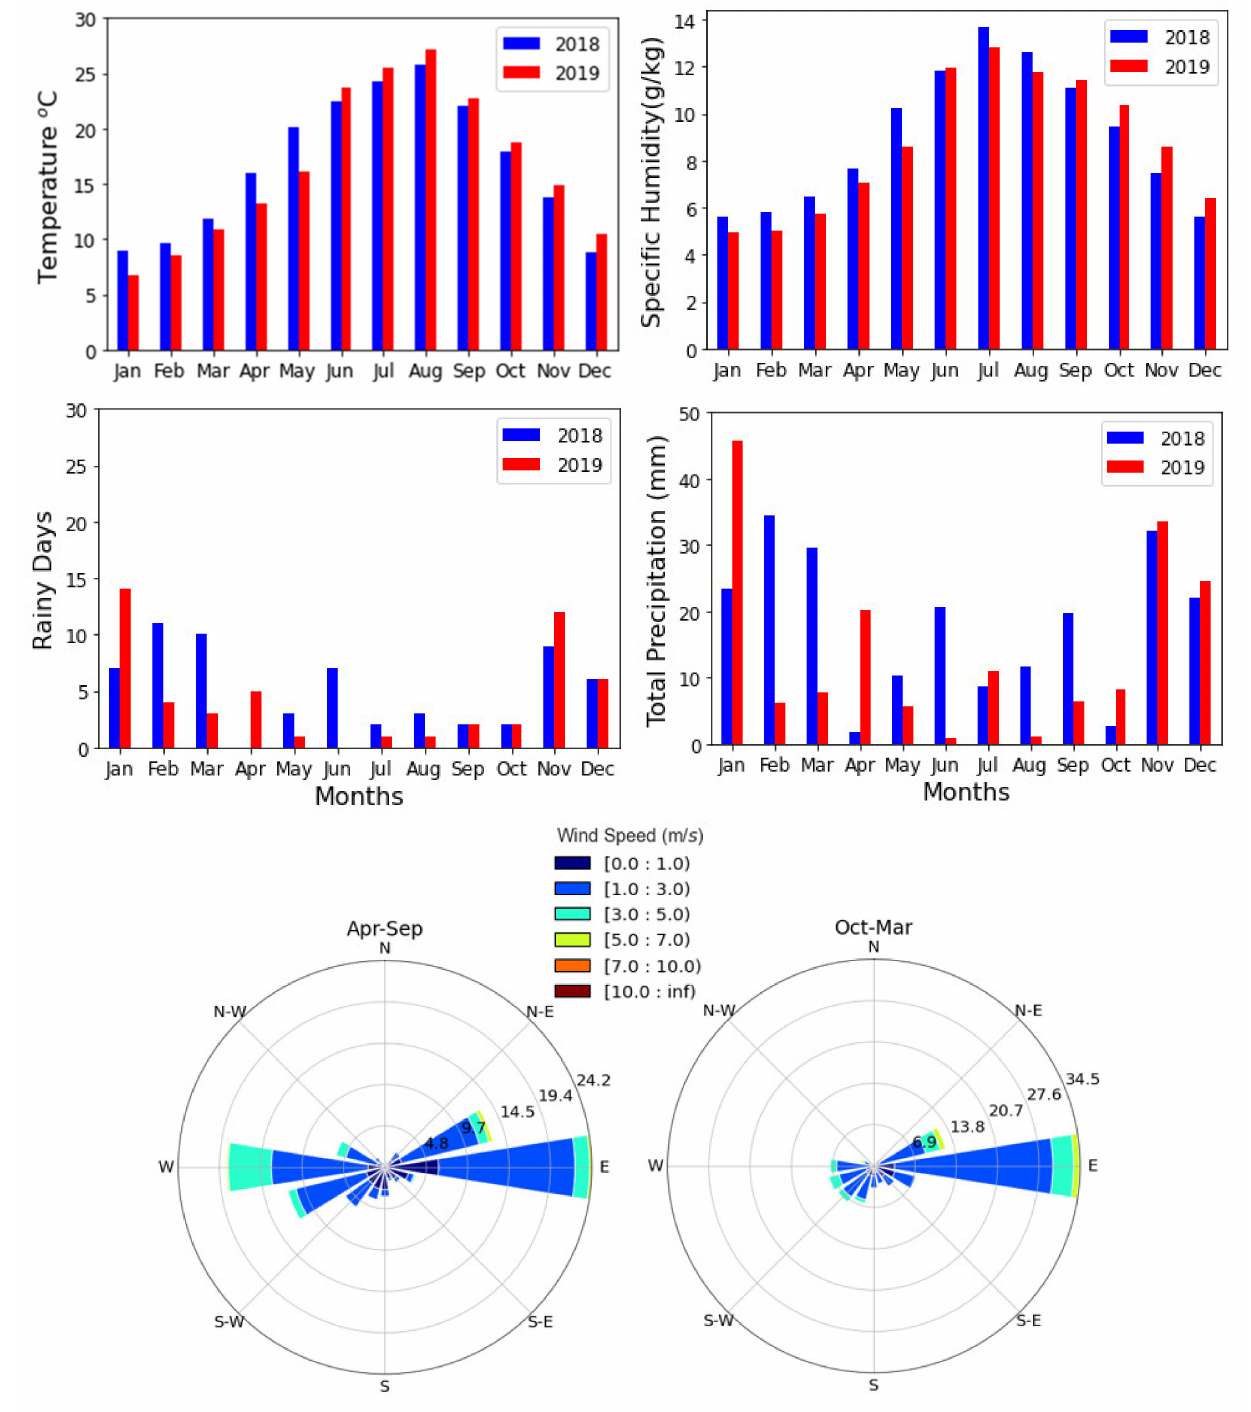
Figure 2. Monthly variations of temperature ( top left ), specific humidity ( top right ), rainy days ( middle left ), total precipitation ( middle right ) and wind rising for the warm season ( bottom left ) and the cold season ( bottom right ), at the study area in the survey period